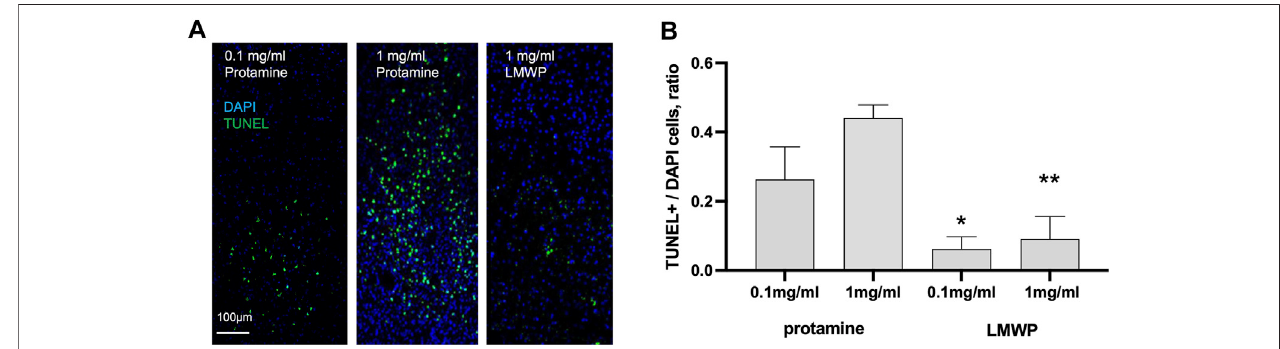
FIGURE 4 | In vivo TUNEL apoptosis assay. (A) TUNEL staining of the mouse brain sacri fi ced 3 days after cortical injections of 0.1 or 1 mg/ml (23.6 or 236 µM) protaminein1.5 µlofPBScomparedto1 mg/ml(532 µM)LMWPin1.5 µlofPBS.DAPIstainingwasusedforcellnucleusdetection. (B) CorticalinjectionofLMWPatthe concentration 0.1 or 1 mg/ml (53.2 or 532 µM) reveals signi fi cantly less toxicity in TUNEL staining in comparison with protamine injection at the concentrations 0.1 or 1 mg/ml (23.6 or 236 µM). * p = 0.0379 compared to protamine at the same mg/ml concentration; ** p = 0.0012, ANOVA followed by pairwise comparison with Fisher ’ s LSD test compared to protamine at the same mg/ml concentration; n = 5.